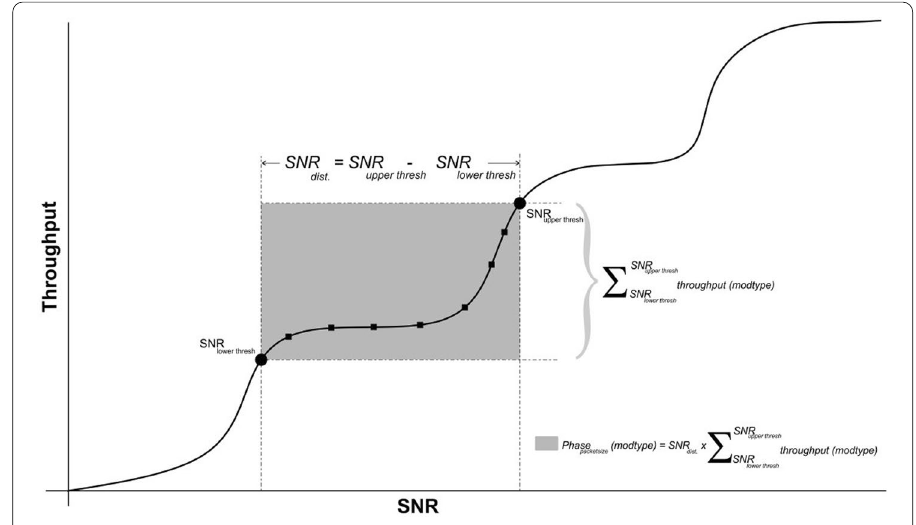
Fig. 7 Productivity phase calculation